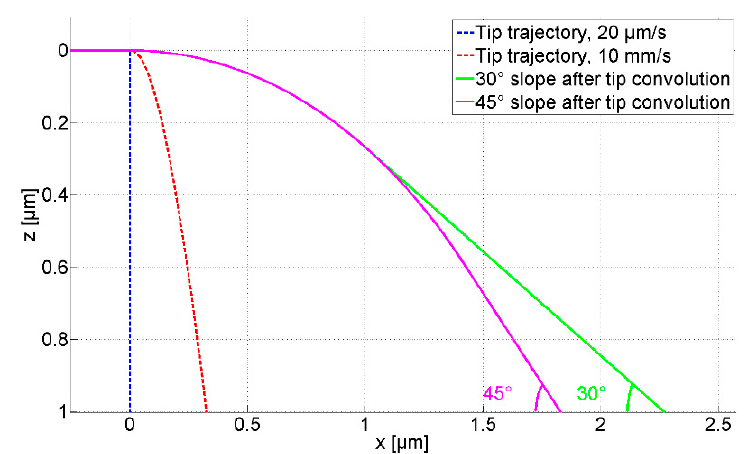
Figure 5. The trajectory of the microprobe with a diamond tip at different traverse speeds, with an initial probing force of 96 µN. Table 1. Nominal parameters of the microprobe used to calculate the cantilever tip trajectories in Figures 3 and 5.